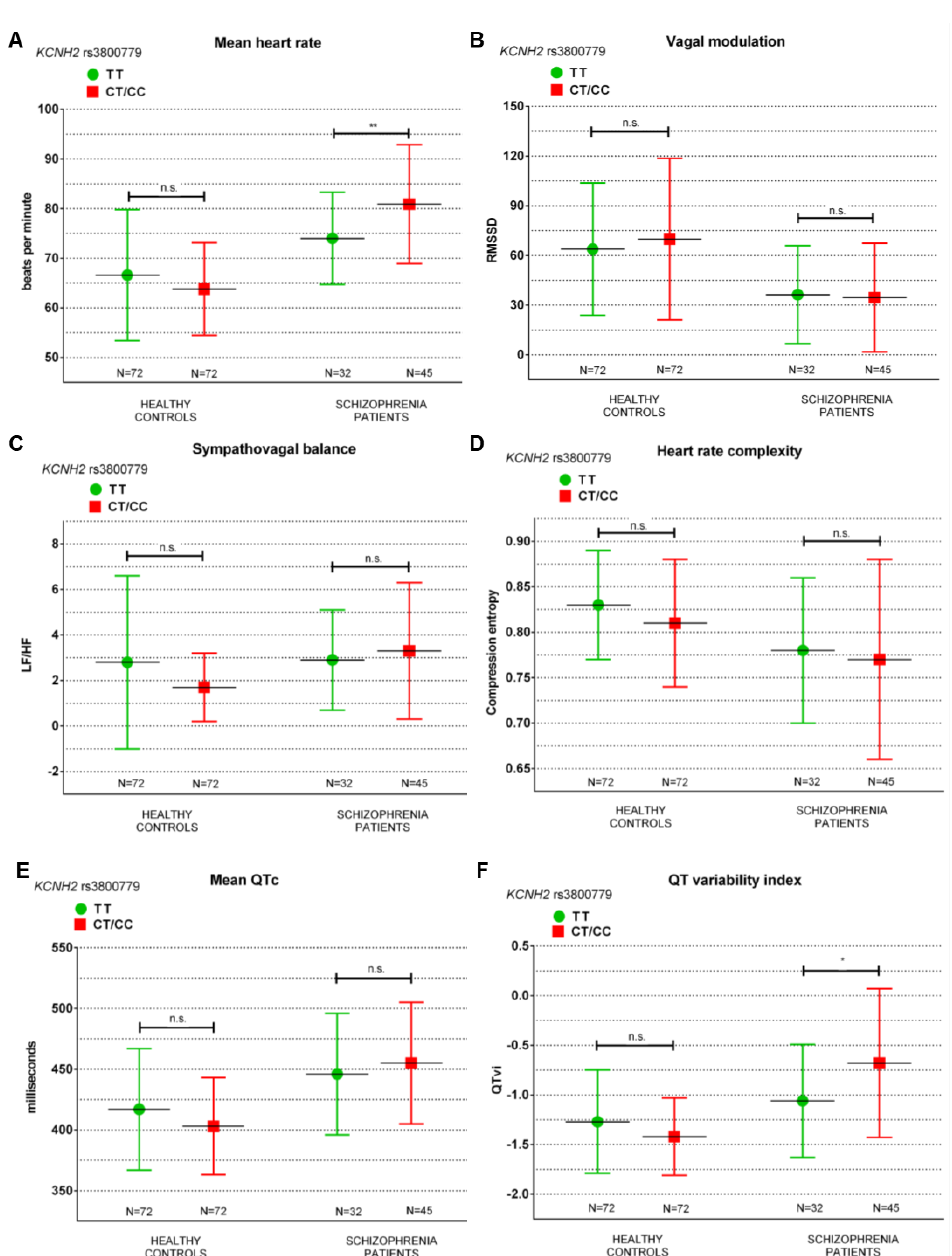
Figure 2. ( A – F ) Error bar chart illustrating differences in mHR (bpm) ( A ), RMSSD ( B ), LF/HF ( C ), Hc ( D ), QTc ( E ), and QTvi ( F ) between genotype risk in KCNH2 rs3800779 (TT vs. CT/CC) separately in unmedicated schizophrenia patients and healthy controls, * p < 0.05, ** p < 0.01, p -value resulting from ANOVAs. Abbrev.: Not significant (n.s.).